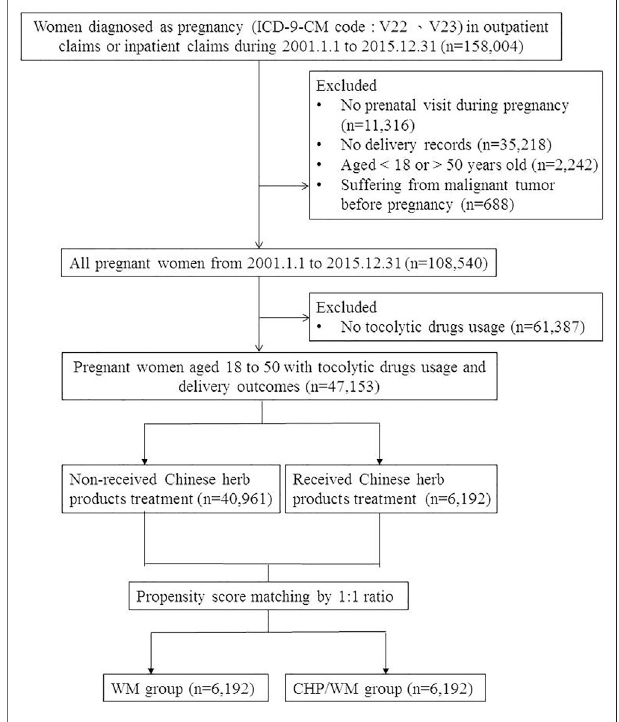
FIGURE 1 | Flow chart of this study